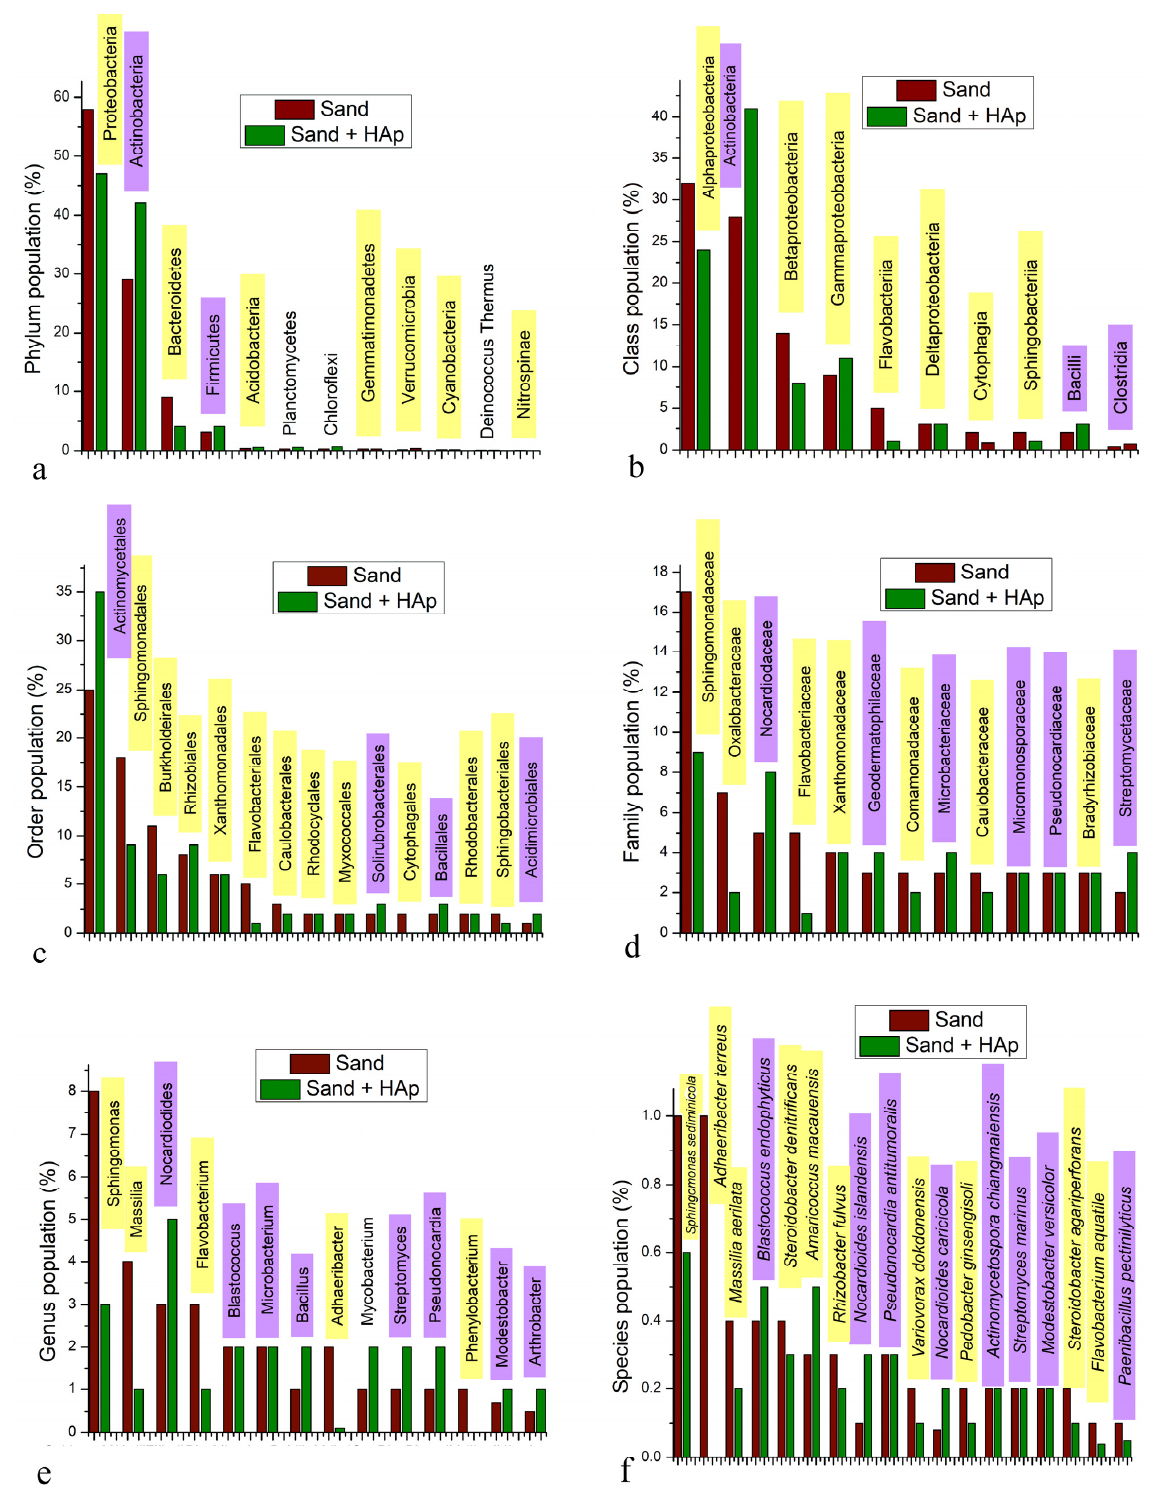
Figure 6. Relative presence of the most dominant phyla ( ≥ 0.05%) ( a ), classes ( ≥ 0.5%) ( b ), orders ( ≥ 2%) ( c ), families ( ≥ 3%) ( d ), genera ( ≥ 1%) ( e ) and species ( ≥ 0.1%) ( f ) in the sandy soil microbiome before and after its treatment with HAp nanoparticles. Gram ‐ negative taxa are framed in yellow, while Gram ‐ positive taxa are framed in violet.